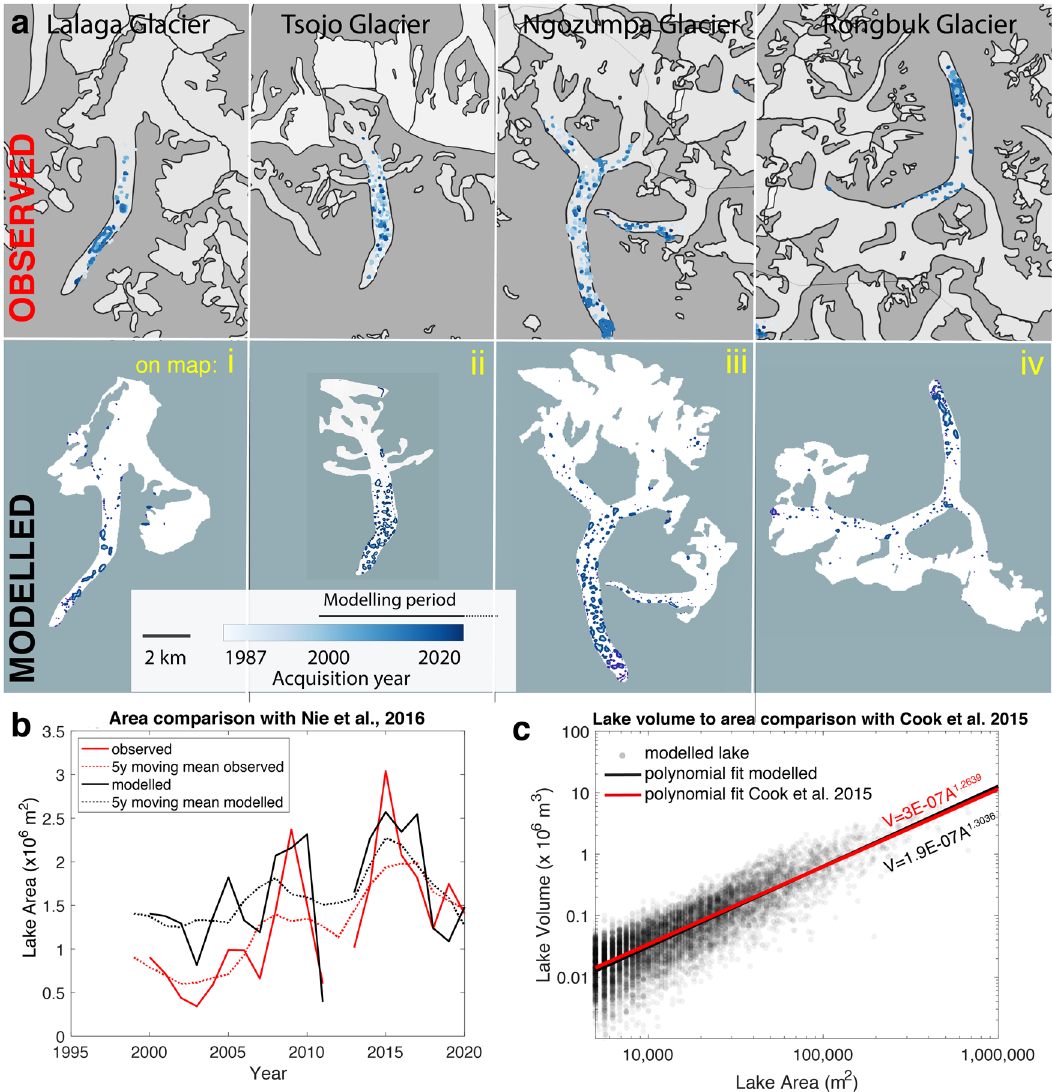
Fig. 2 Validation of model results. a Qualitative comparison between observed lakes between 1987 and 2020 2,67 and model results (1999 – 2020) for Lalanga, Tsojo, Ngozumpa and Rungbu glaciers. Glacier locations are shown by yellow roman numerals in Fig. 5. b Evolution of the total area for observed ice-dammed lakes 2,67 and model results for the four glaciers in ( a ). Each observed lake is compared with the closest modelled lake, and the results are then aggregated per year. Note that there were no observations in 2012. c Relationship between lake area and lake volume as observed 65 (red) and modelled (balck). Each black circle is a modelled lake, while the black line is a second-order polynomial fi t. The polynomial fi t of Cook et al. 2015 (ref. 65 ) is based on nine observed supraglacial